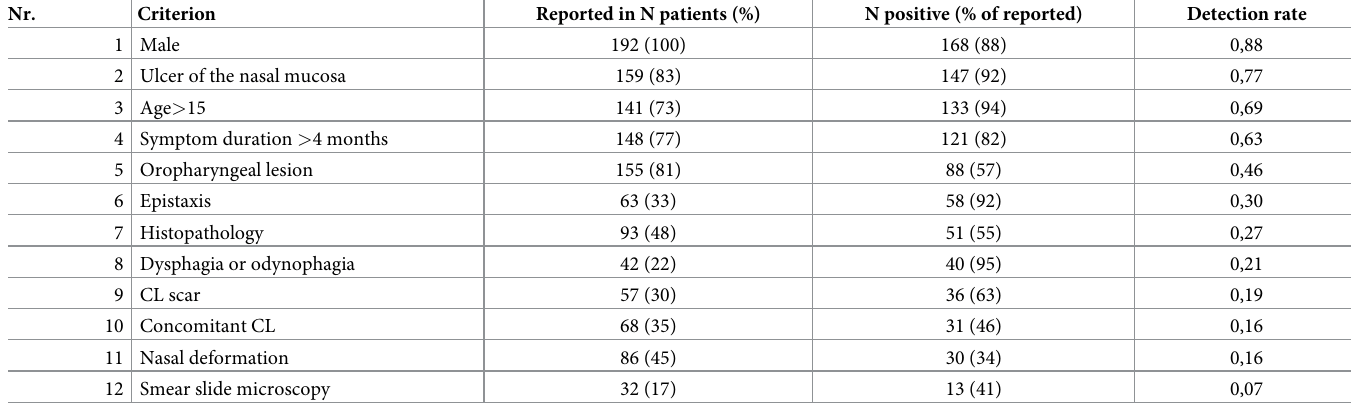
Table 4. Arrangement of the clinical criteria from the highest absolute number of patients positive to the lowest. Nr.